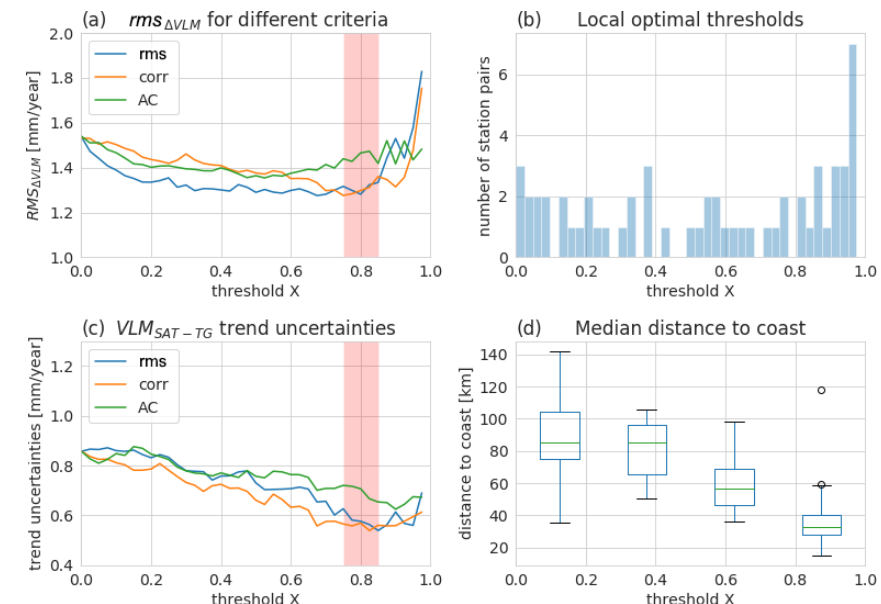
Figure 5. Performance of VLM SAT-TG trend estimates for ALES–GESLA–ZOI; (a) rms (cid:49) VLM for different relative thresholds (step size 2.5%) and different selection criteria: rms SAT-TG (blue), correlation (red) and residual annual cycle (AC, green). (c) Same as (a) but for median uncertainty. (b) Distribution of best-performing relative thresholds for individual stations. The local optimal threshold is defined at the minimum of the absolute difference of VLM SAT-TG and GNSS trends. (d) The box plot shows the distribution of the mean distances to the coast for the individual optimum ZOIs as denoted in (b) . The distances refer to the distributions within the 0%–25% and 25%–50%